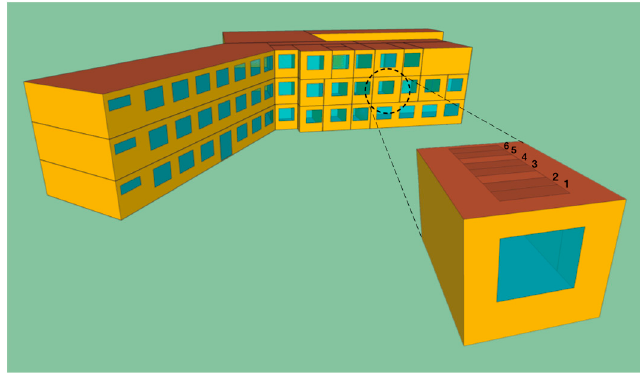
Figure 3. View of the maternity unit building and focus on the patient room analysed.